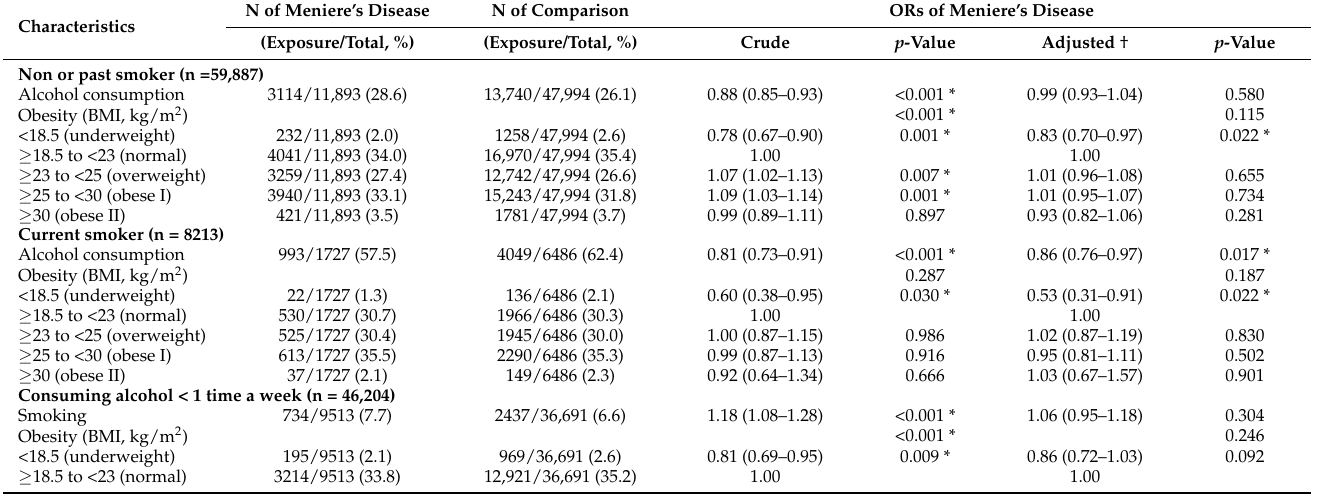
Table 4. Crude and adjusted odd ratios (95% confidence interval) of smoking, alcohol consumption, and obesity for Meniere’s disease in each group. * Unconditional logistic regression analysis, signifi- cance at p < 0.05. † Adjusted model for age, sex, income, region of residence, Charlson comorbidity index, obesity, smoking state (current smoker compared to nonsmoker or past smoker), frequency of alcohol consumption ( ≥ 1 time a week compared to <1 time a week), SBP, DBP, fasting blood glucose, total cholesterol, dyslipidemia, benign paroxysmal vertigo, vestibular neuronitis, and other peripheral